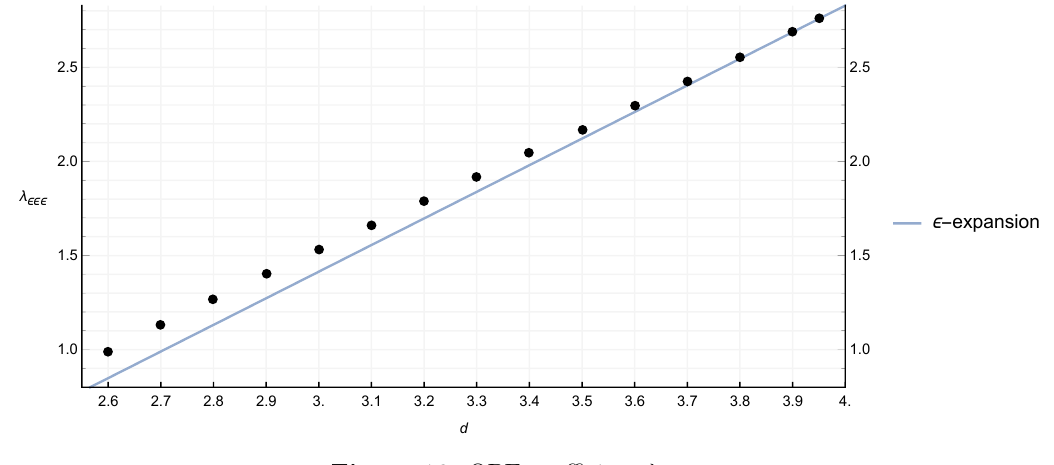
Figure 19 . OPE coefficient λ